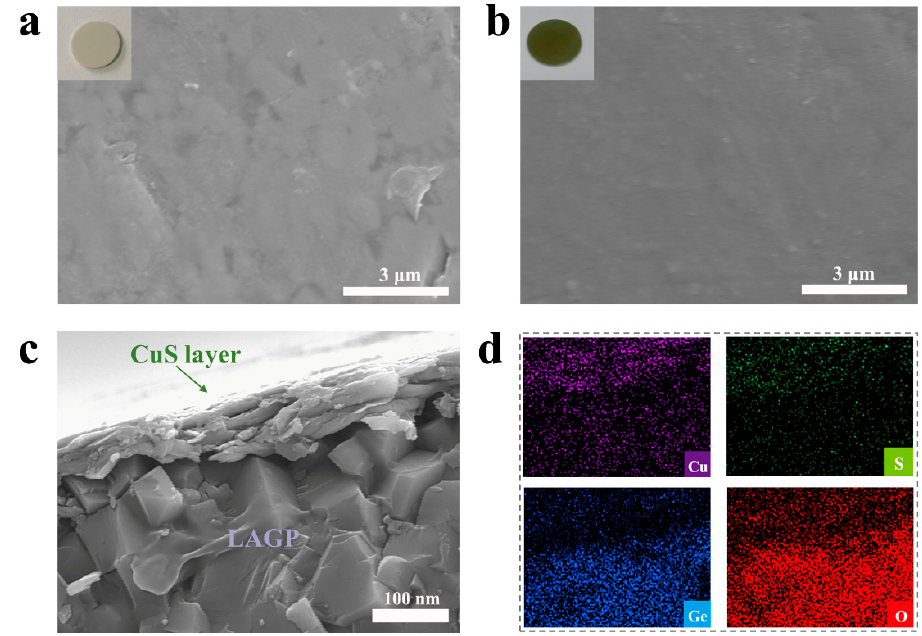
Figure 2. Top-view SEM images: ( a ) planar of the original LAGP pellet and inserted optical photo- graph and ( b ) CuS@LAGP pellet and inserted optical photograph. ( c ) Cross-sectional SEM images of the CuS@LAGP pellet and ( d ) its corresponding high-resolution mapping.